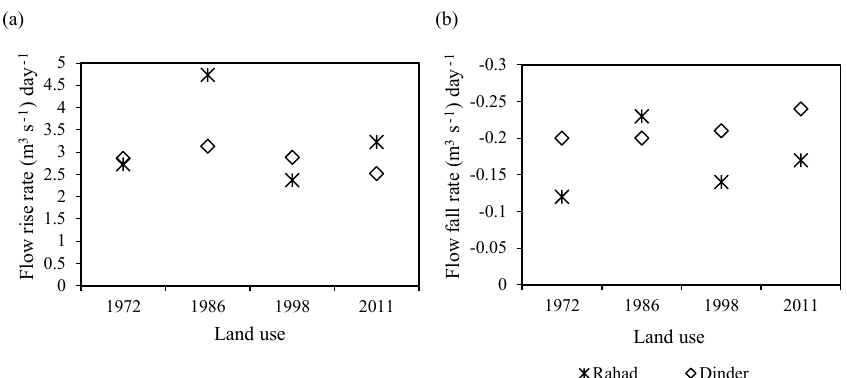
Figure 13. The rate of flow rises (a) and falls (b) as a response to land use data from 1972, 1986, 1998 and 2011 for both Rahad and Dinder rivers (negative sign in the vertical axis indicates downward direction of